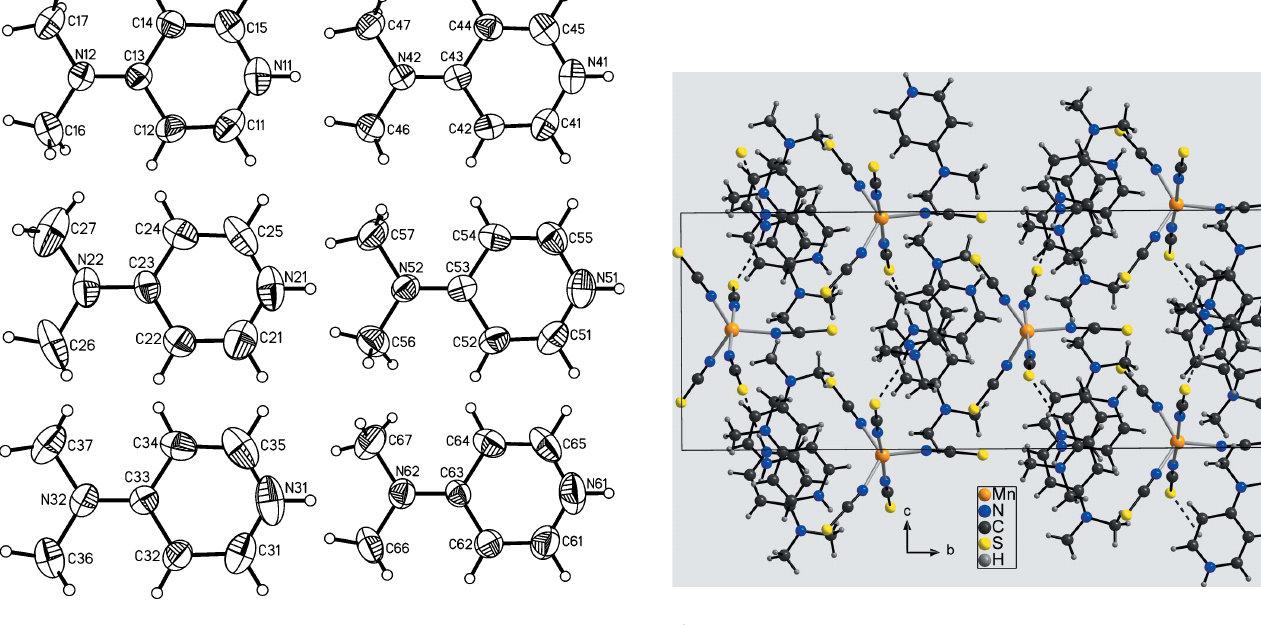
Figure 6 Crystal structure of compound 2 in a view along the a axis. Intermolecular hydrogen bonding is shown as dashed lines. The polar character of this structure is emphasized by the same orientation of the complex anions relative to the b